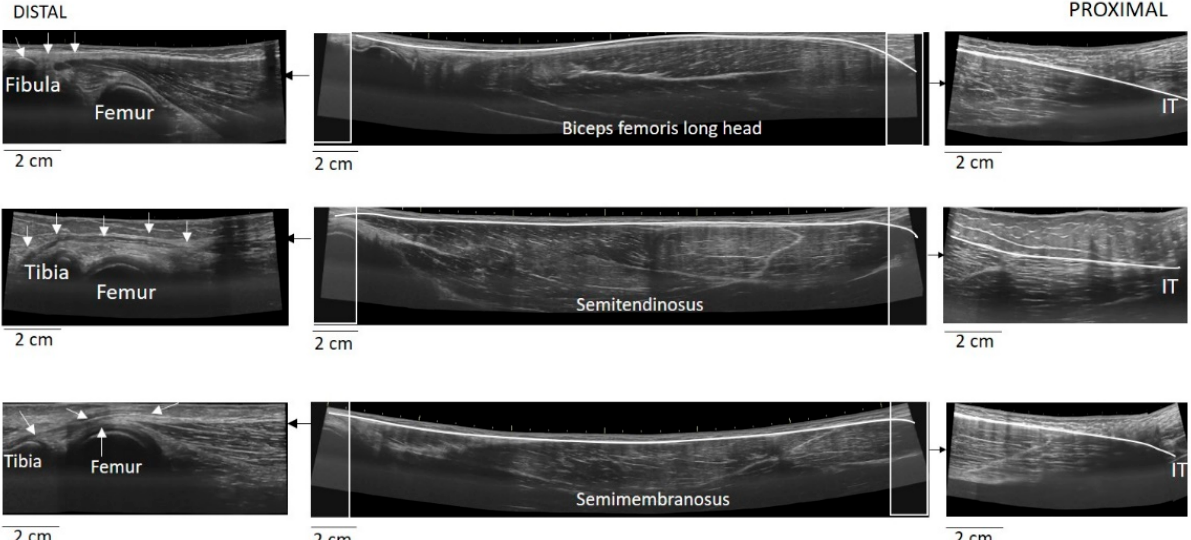
Figure 3. Measurement of muscle-tendon unit using EFOV-US technique. In each panel of images, the center image presents each muscle-tendon unit, scanned from the distal to proximal end. To better illustrate the identification of the attachments, zoomed EFOV-US images of the distal (left side) and proximal (right side) are also included. White arrows illustrate the path of each distal tendon. Using the segmented line tool of the ImageJ software, the superficial aponeurosis was digitised and the total line length was considered as the muscle-tendon unit (IT = ischial tuberosity).